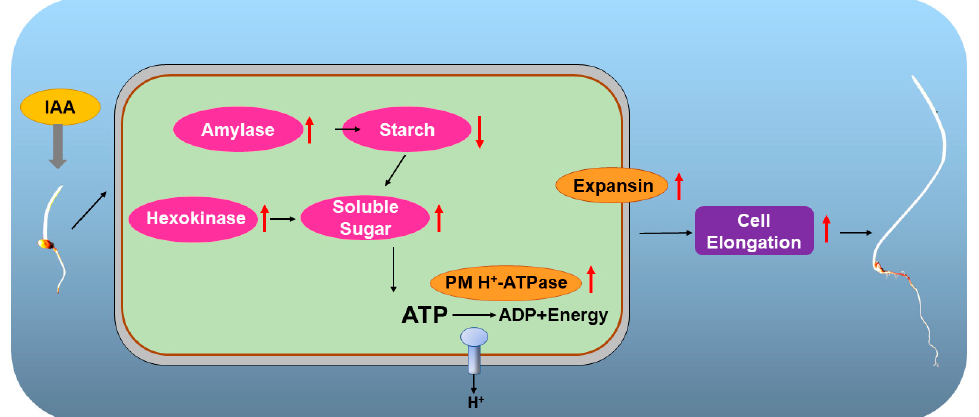
Figure 10. A flowchart of exogenous IAA elongate sorghum mesocotyl by energy metabolism and membrane acidification.